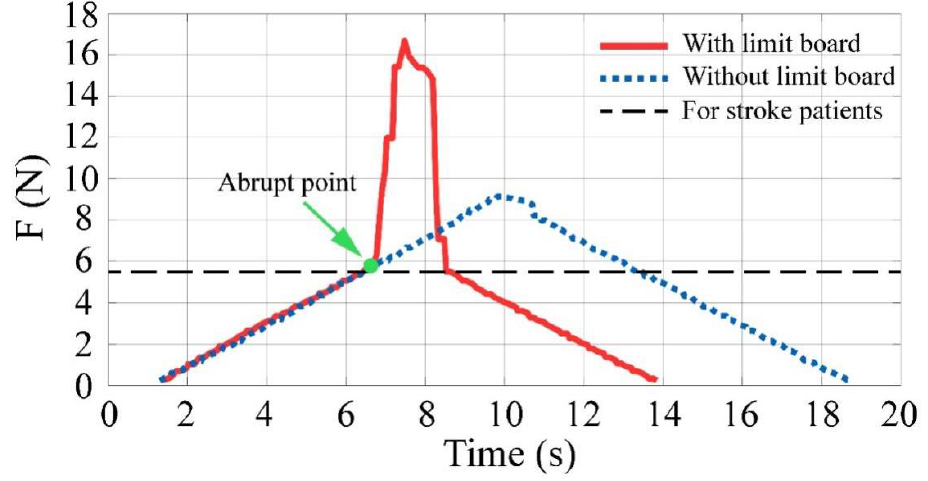
Figure 8. Results of the stretching force of VSFH for stroke patients.